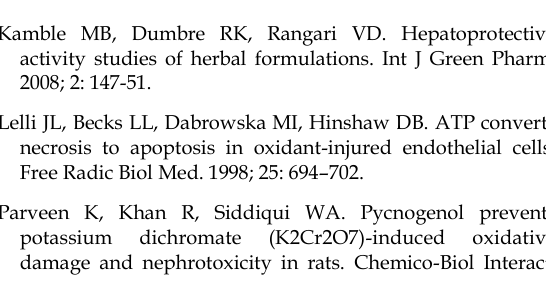
Figure 3: Effect of aqueous extract of leaves of Sechium edule on streptozotocin-induced diabetic nephropathy in mice A: Normal control; B: Treated with streptozotocin (55 mg/kg, i.p.); C: Treated with glibenclamide (10 mg/kg) and streptozotocin (55 mg/kg. i.p.); D: Treated with Sechium edule (200 mg/kg); E: Treated with Sechium edule (100 mg/kg) and streptozotocin (55 mg/kg,